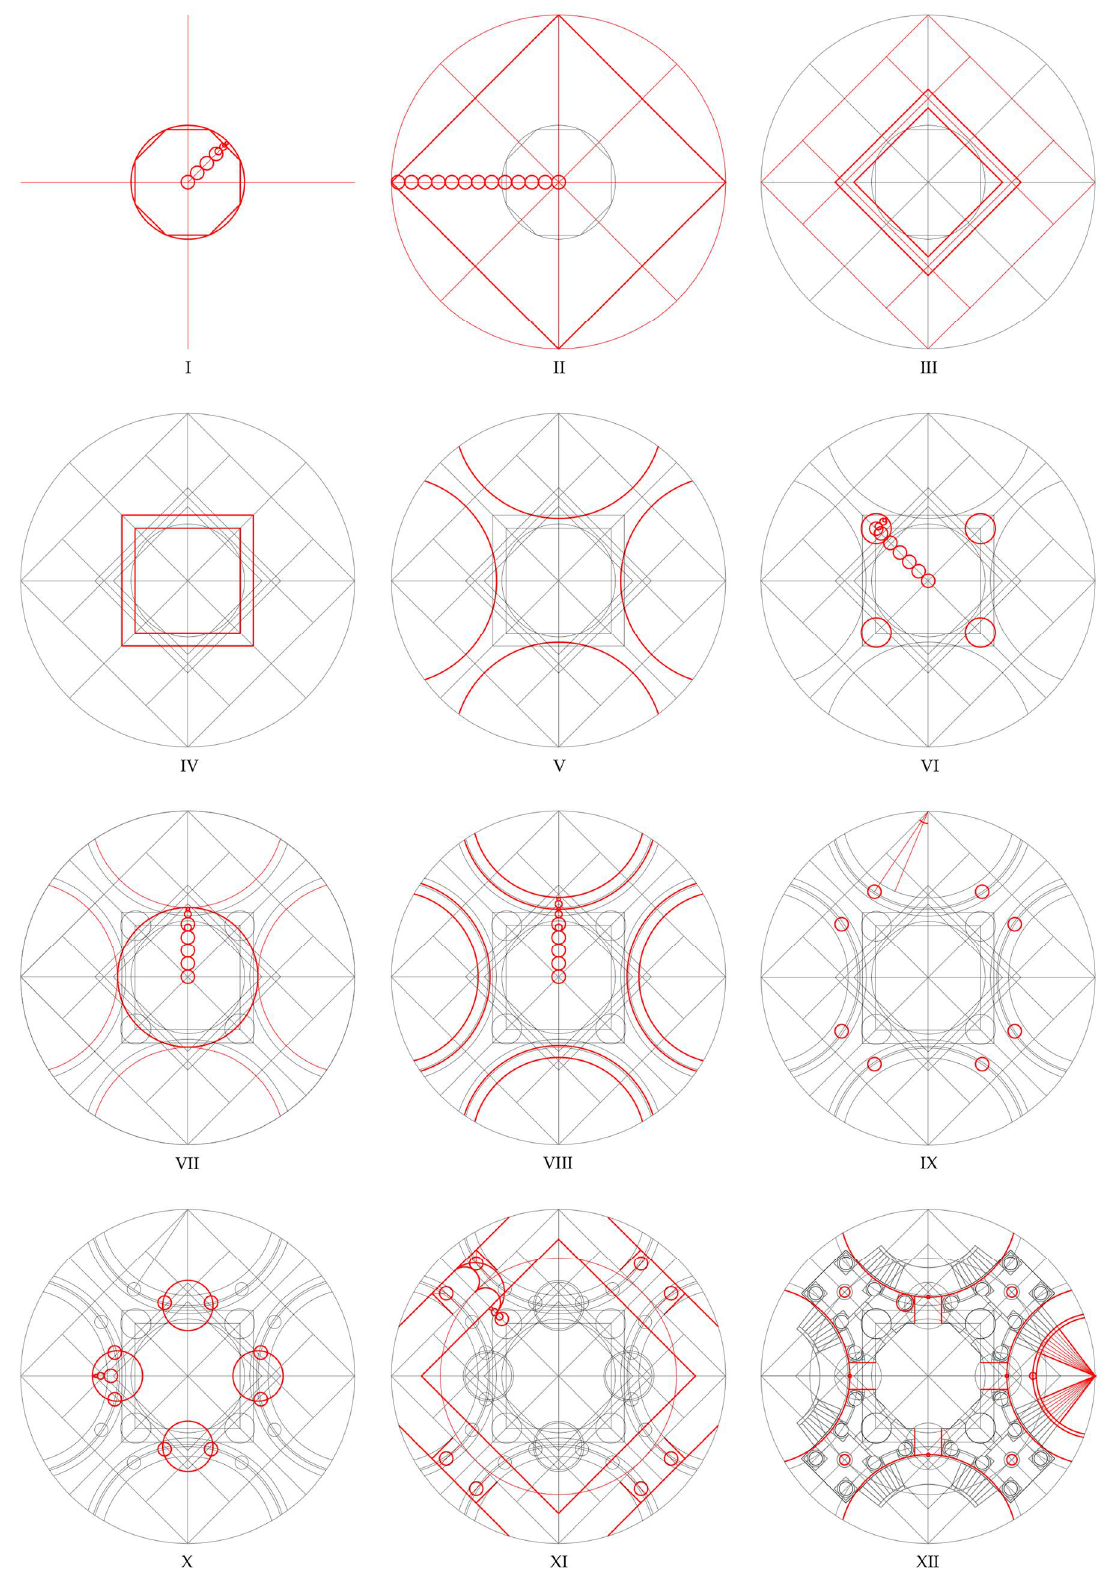
Figure A2. Geometrical proportional scheme to create the plan de-composed in 12 essential passages: starting from the central octagon, the wall cell, the position of columns in the peristyle, the limit of the base, the openings and stairway are